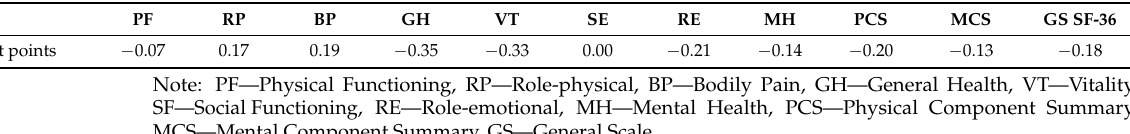
Table 7. Correlation of the obtained Ghent points and a quality of